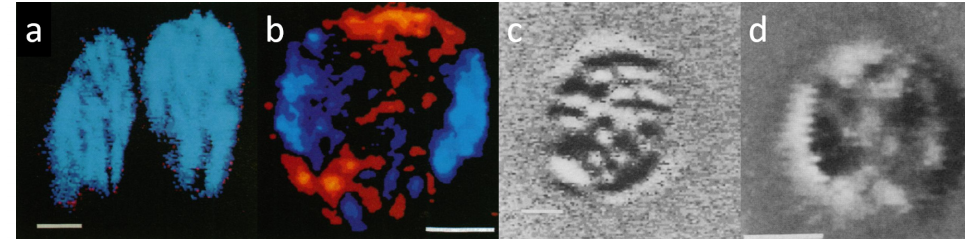
Figure 2. Confocal LD and CD images (( a – d ) respectively) of isolated magnetically oriented spinach TMs trapped in edge-aligned ( a , c ) and face-aligned ( b , d ) positions. Blue and red false colours stand, respectively, for positive and negative LD with respect to the membrane plane ( a , b ); black and white domains ( c , d ) indicate local CD signals of opposite signs. Bar is 2 µ m. (Composed from parts of figures published in [24]).